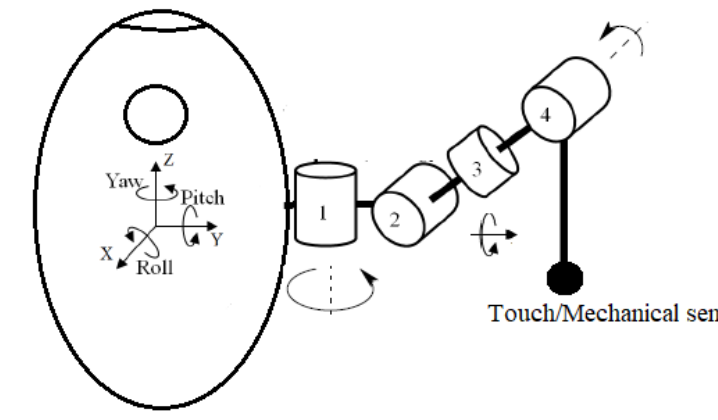
Figure 10. Concept design of the leg and joints.